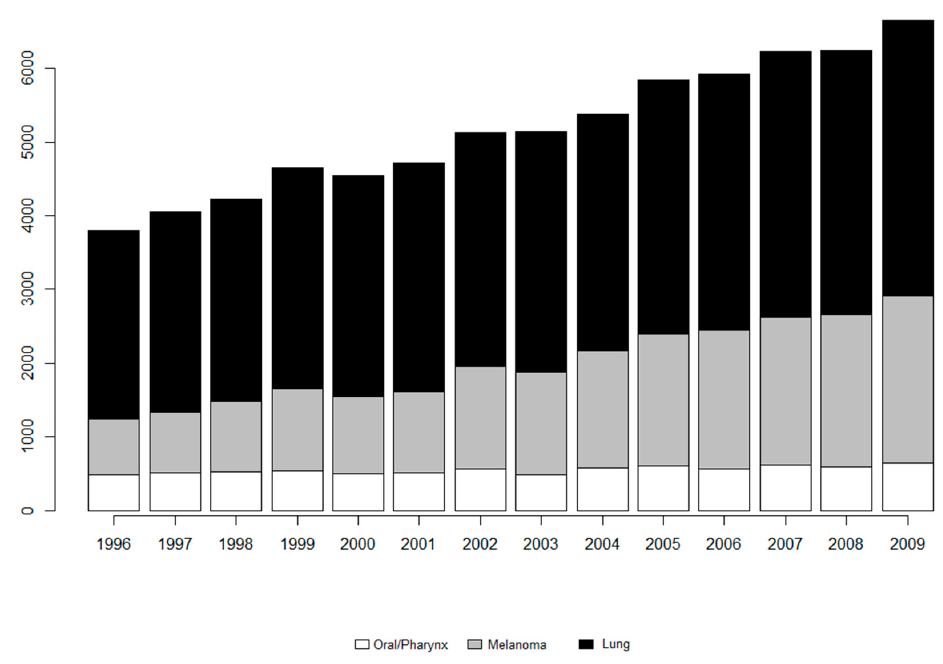
Figure 1. Bar plot of incidences of all cancers over time.